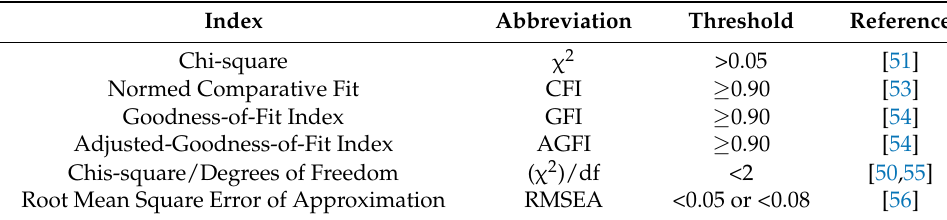
Table 4. Goodness-of-Fit Indices and Thresholds.